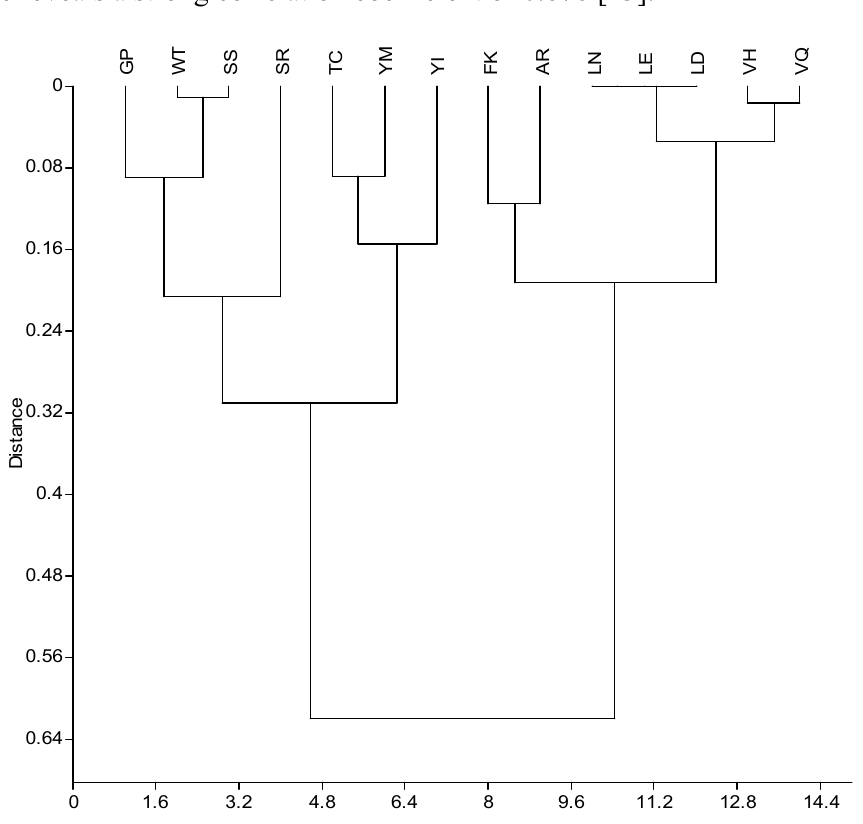
Figure 1. Clustering of complementary amino acid pairs by means of Kyte & Doolittle hydropaty values (3’ → 5’ direction). Paired group algorithm with Gower similarity measure reveals a strong correlation coefficient of 0.878